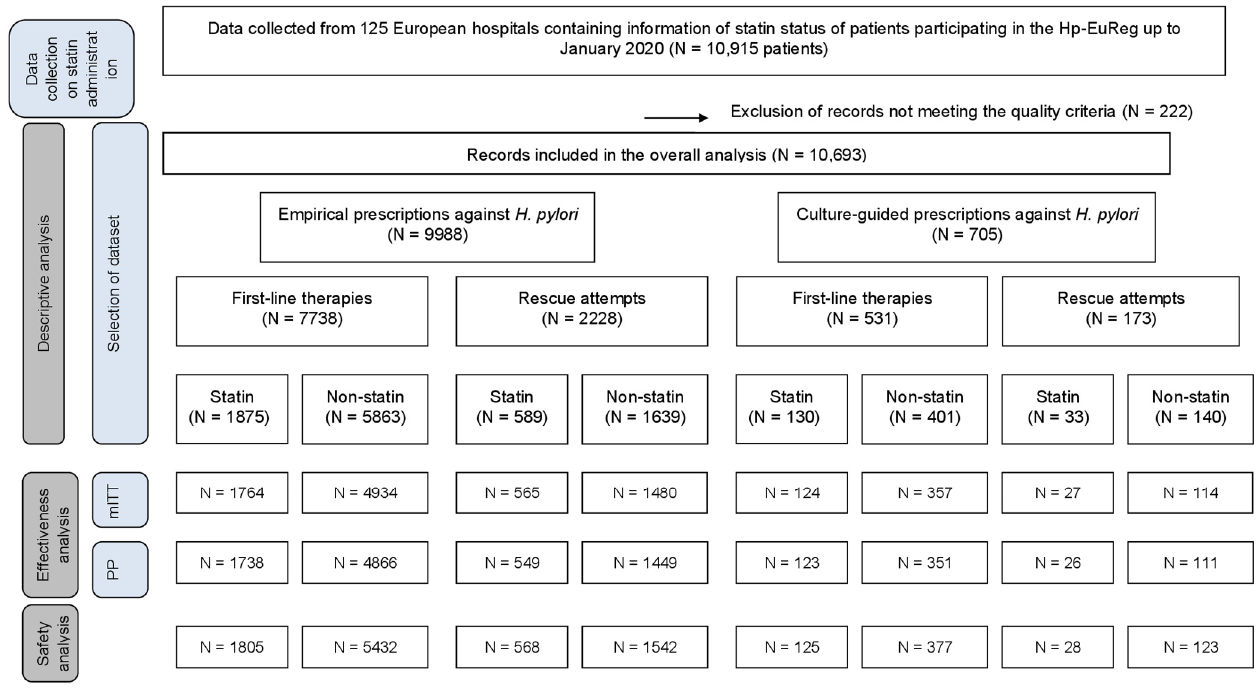
Figure 1. Flowchart of the patients included. N = number of patients treated. mITT = modified intention-to-treat analysis. PP = per protocol analysis. Table 1. Demographic analysis and use of